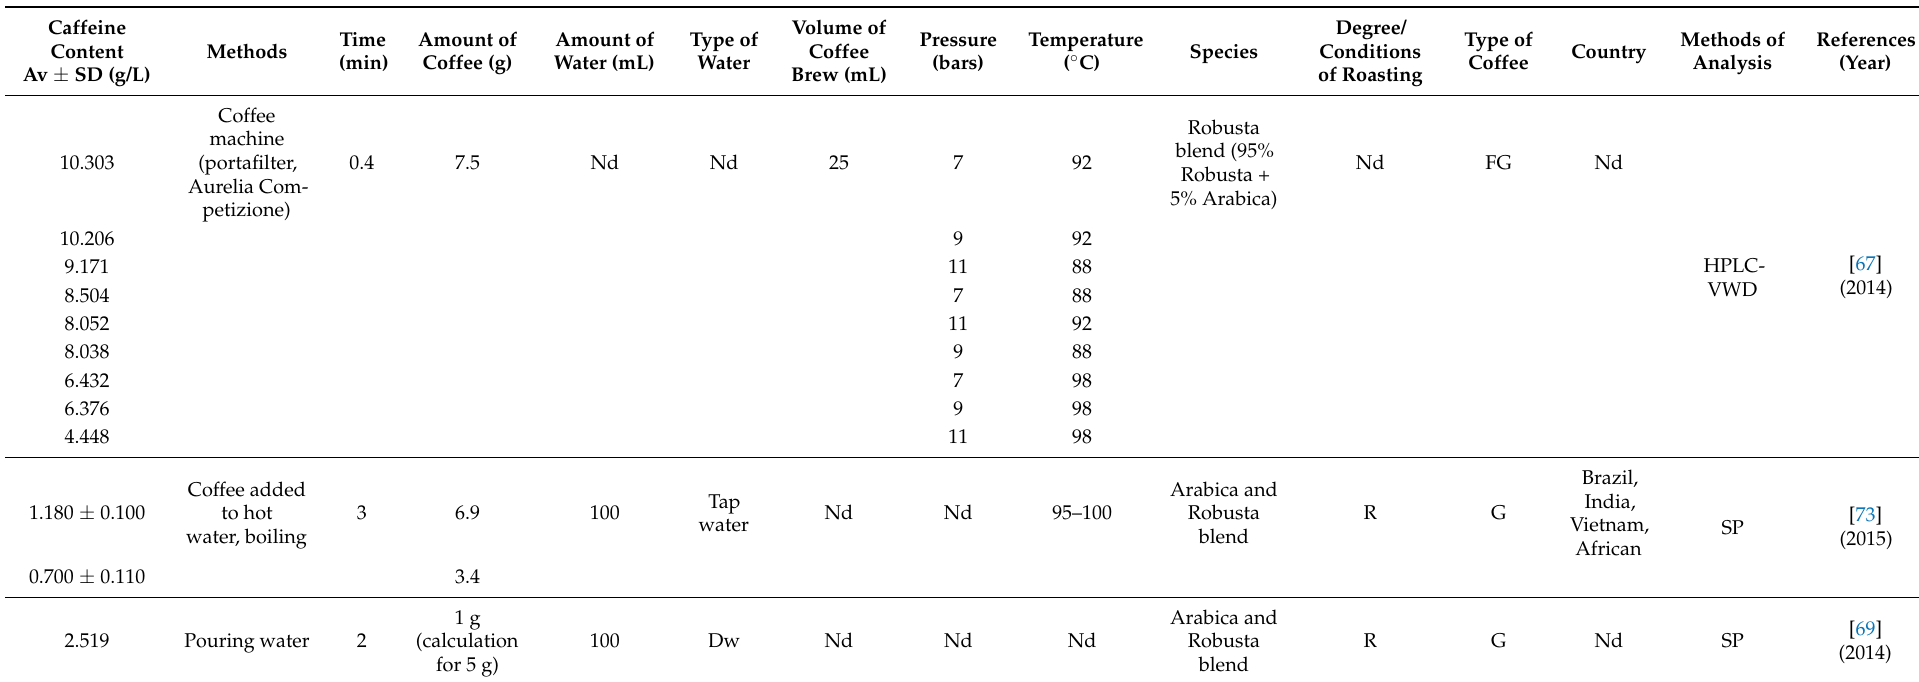
Table 3. Caffeine content (g/L) in a blend of Arabica and Robusta coffee